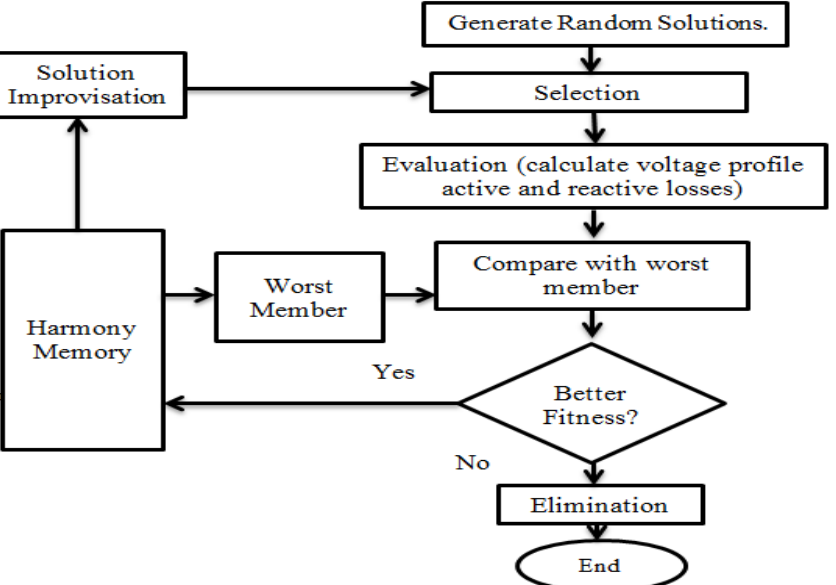
Figure 3. Harmony Search Algorithm (HSA) flowchart.